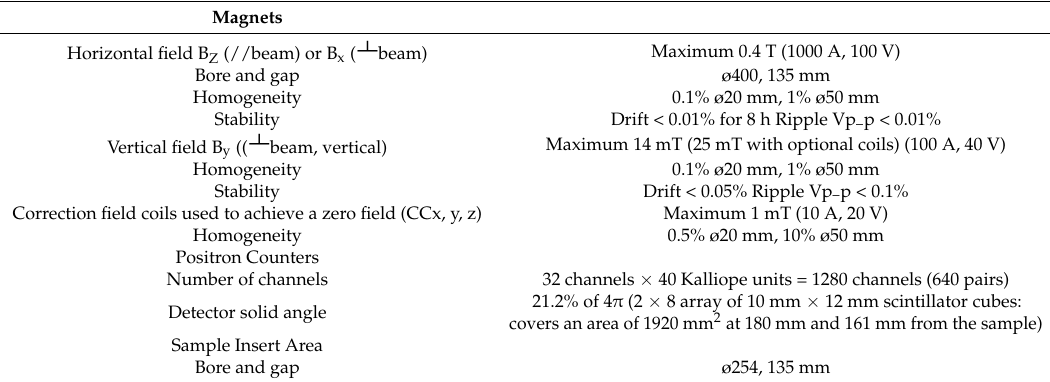
Table 2. Specifications of the twin µ SR spectrometers in areas D1 and